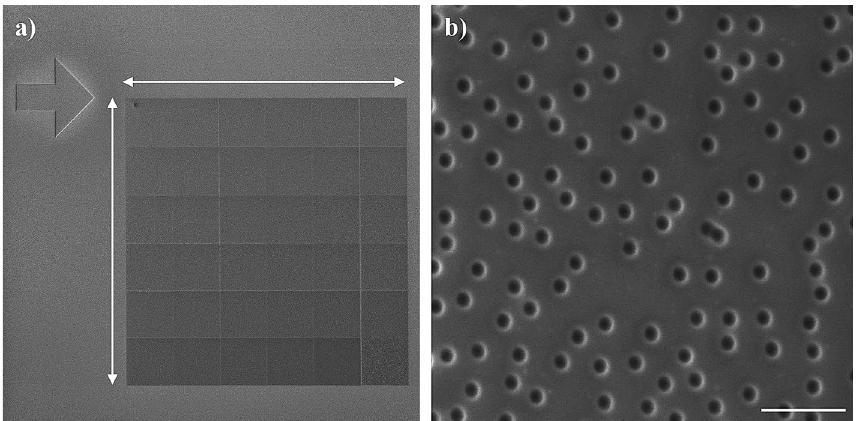
Figure 1. ( a ) Overview of the nanopatterned array with an area 540 × 540 µm 2 consisting of 1,361,700 holes on the silicon mold. ( b ) The detailed view of the array of big (30 kV, 160 pA) holes (scale bar 1 µm). Images were acquired by SEM (5 kV, 160